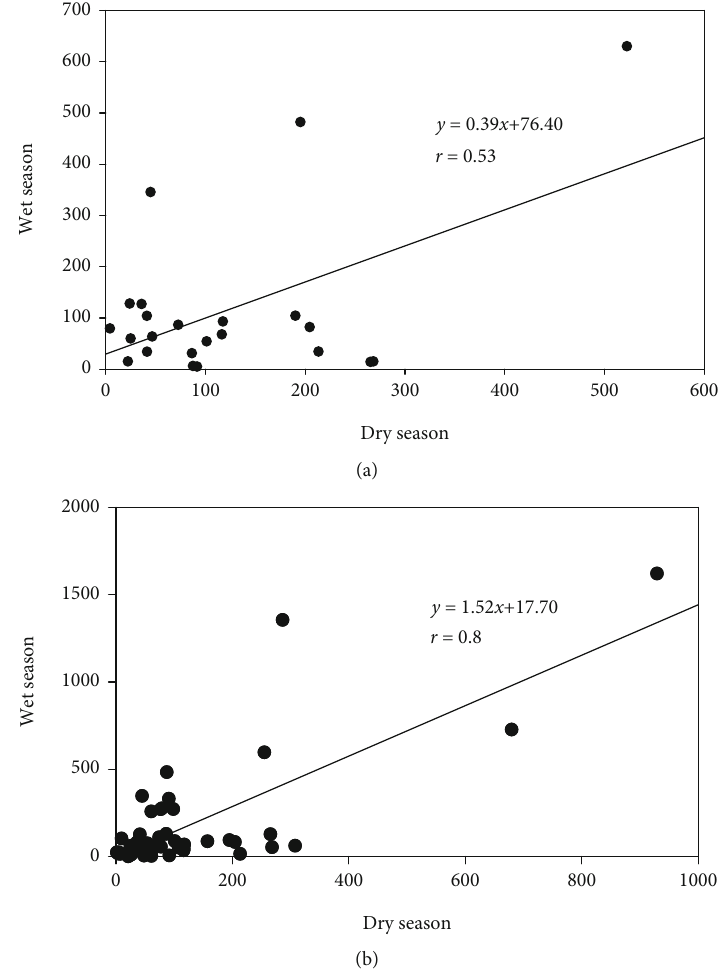
Figure 5: Correlation coe ffi cient for nitrates in (mg/L) between the wet and dry seasons in (a) boreholes and (b) in shallow